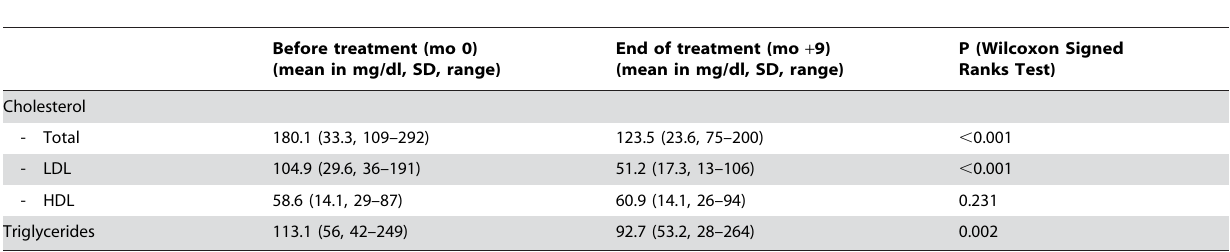
Table 3. Change of cholesterol and triglyceride serum levels under treatment with atorvastatin in the evaluable study population (n=36). SD: standard deviation.